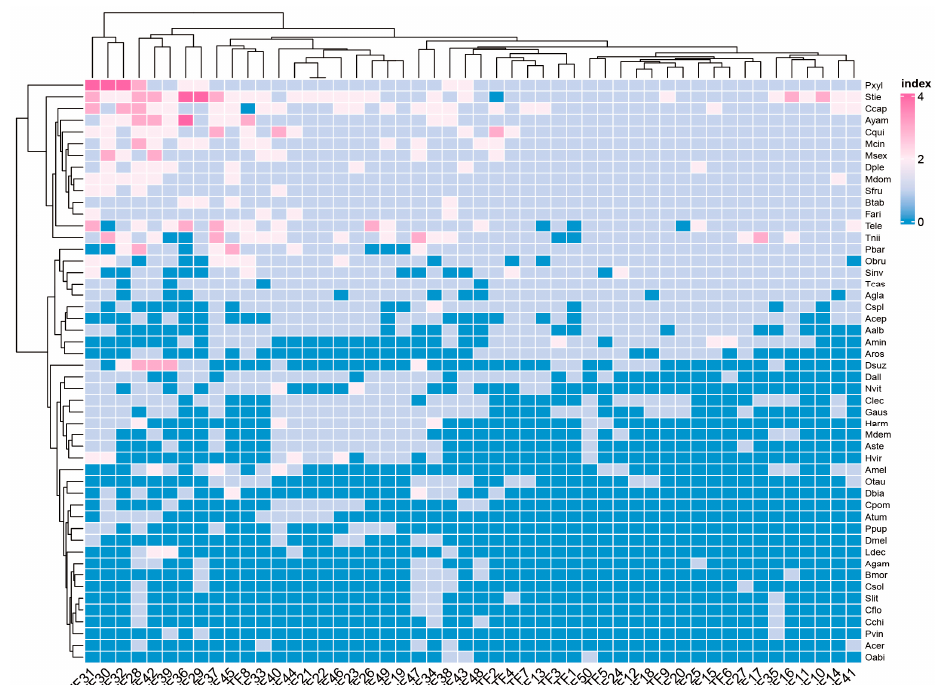
Figure 3. Characteristic heat map of NMF, the vertical axis is the name of insects, and the horizontal axis is the eigenvalues of different features. See Table S2 for the names of species assigned to each label.